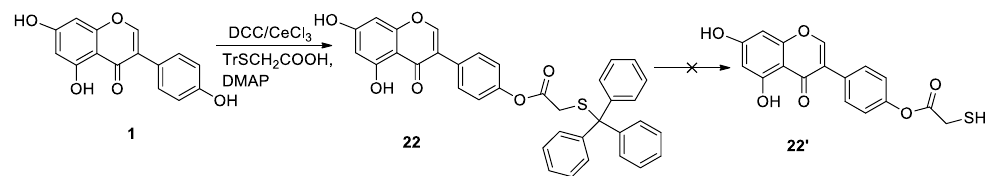
Molecules 2020 , 25 , x FOR PEER REVIEW 5 of 19 Figure 2. Structures of thiol derivatives of flumethasone ( 16 ), fluticasone propionate ( 17 ), ursolic acid methyl ester ( 18 ), and β-sitosterol ( 19 ). Unfortunately, our efficient two-step procedure of thiol derivative preparation failed in the case of genistein ( 1 ) completely, and no product of 2-(tritylthio)acetic acid esterification was detected. Despite the use of higher equivalents of DCC or EDCI, the elongation of reaction time, the change of solvent (DCM (dichloromethane), THF, DMF), or the temperature increase, only the unreacted substrates were observed in the reaction mixture. Perhaps, the difficulty to directly produce genistein ( 1 ) ester is caused by lower nucleophilicity of the phenolic OH-groups and/or by inter- and intramolecular hydrogen bond formation (for example between 5-OH and 3-C=O). This effect